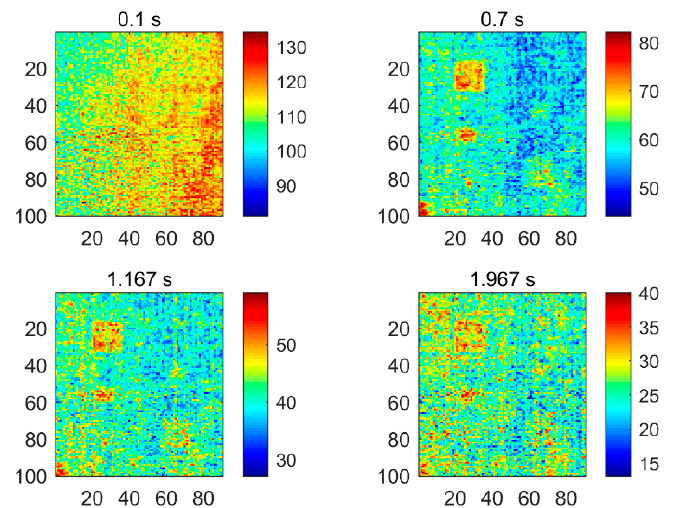
Figure 6. The PT thermograms of specimen 2 recorded at different sampling instances.